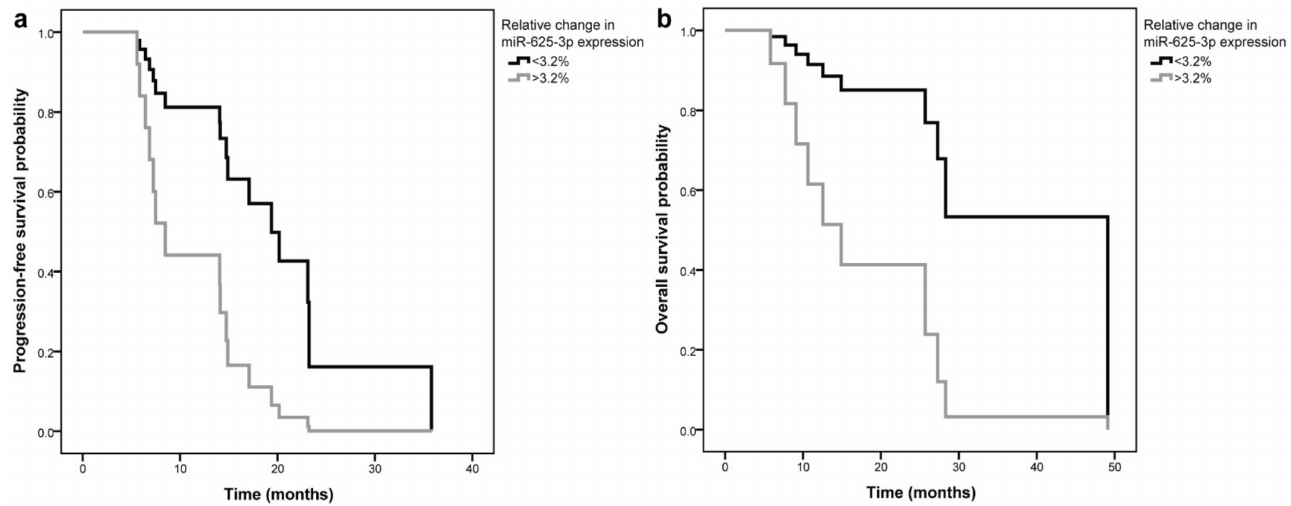
Figure 1. Relative change in serum EV-enriched miR-625-3p expression and progression free survival ( a ) and overall survival ( b ) of malignant mesothelioma patients. EV: extracellular